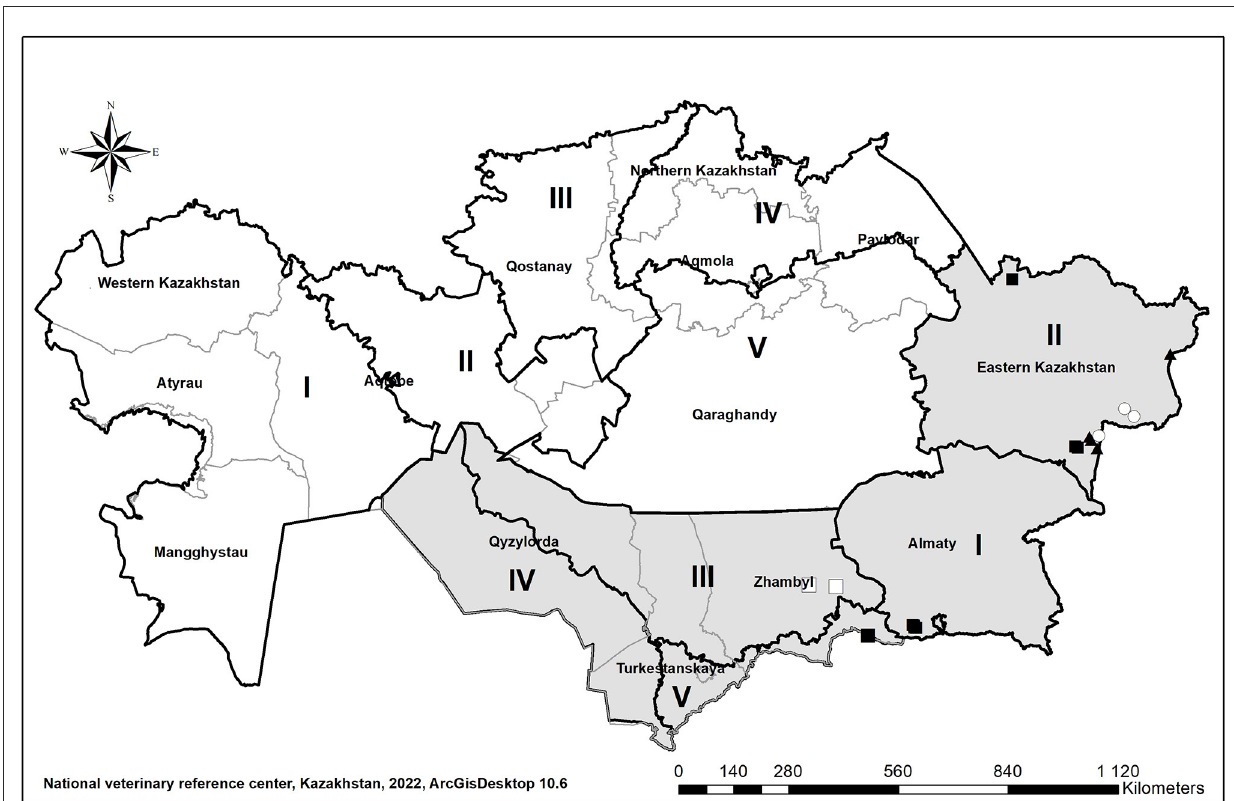
FIGURE1 The fourteen administrative units of Kazakhstan (thin borders) grouped into ten zones (thick borders designated in Roman, I–V, numerals) according to their foot-and-mouth disease (FMD) status (gray: with vaccination; white: without vaccination), as approved by the World Organization for Animal Health (WOAH) in 2019. FMD outbreaks reported in 2011 (triangles), 2012 (squares), and 2013 (circles) caused by serotype O (black) and serotype A (white) FMD viruses are also